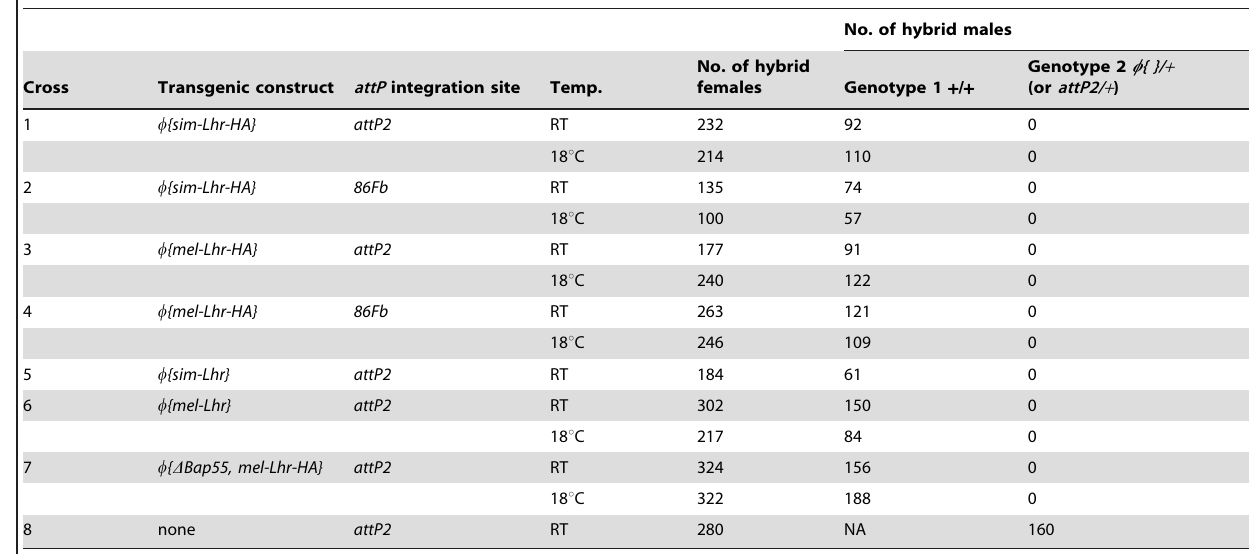
attP2 160 Crosses were between D. melanogaster females heterozygous for the different transgenes tested ( w; Q {transgene, w + } ) and D. simulans Lhr 1 males. Transgenes are denoted as w {} in the table. The transgenes carry a copy of the w + gene so the hybrid sons inheriting the transgene (genotype 2) were distinguished from their control siblings (genotype 1) by their eye-colour, except for cross 8 where D. melanogaster females homozygous for the integration site without an inserted transgene were mated to D. simulans Lhr 1 males. NA=not applicable. RT=room temperature.